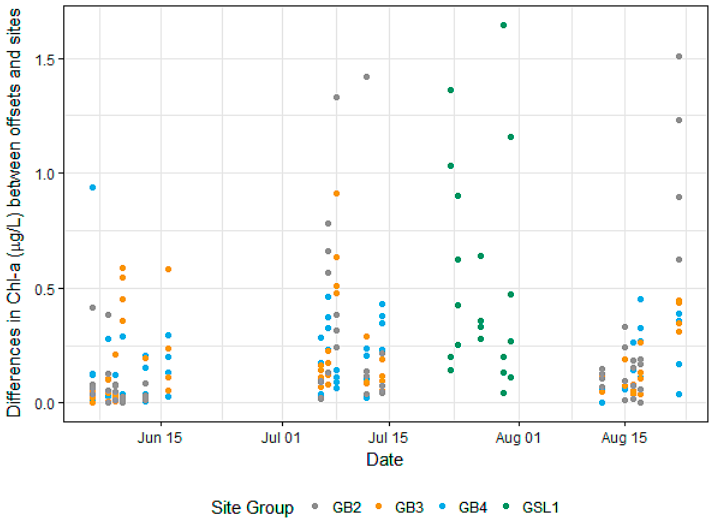
Figure 6. Variability between Sites and Offsets (<30 m distances or Sub-Landsat/Sub-SENTINEL-2 Scales) in the Great Salt Lake (GB and GSL Sites).